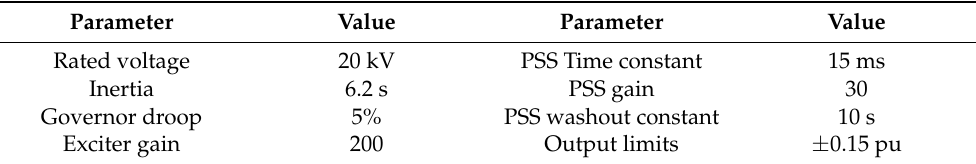
Table 4. The values of the parameters of the synchronous power plant.